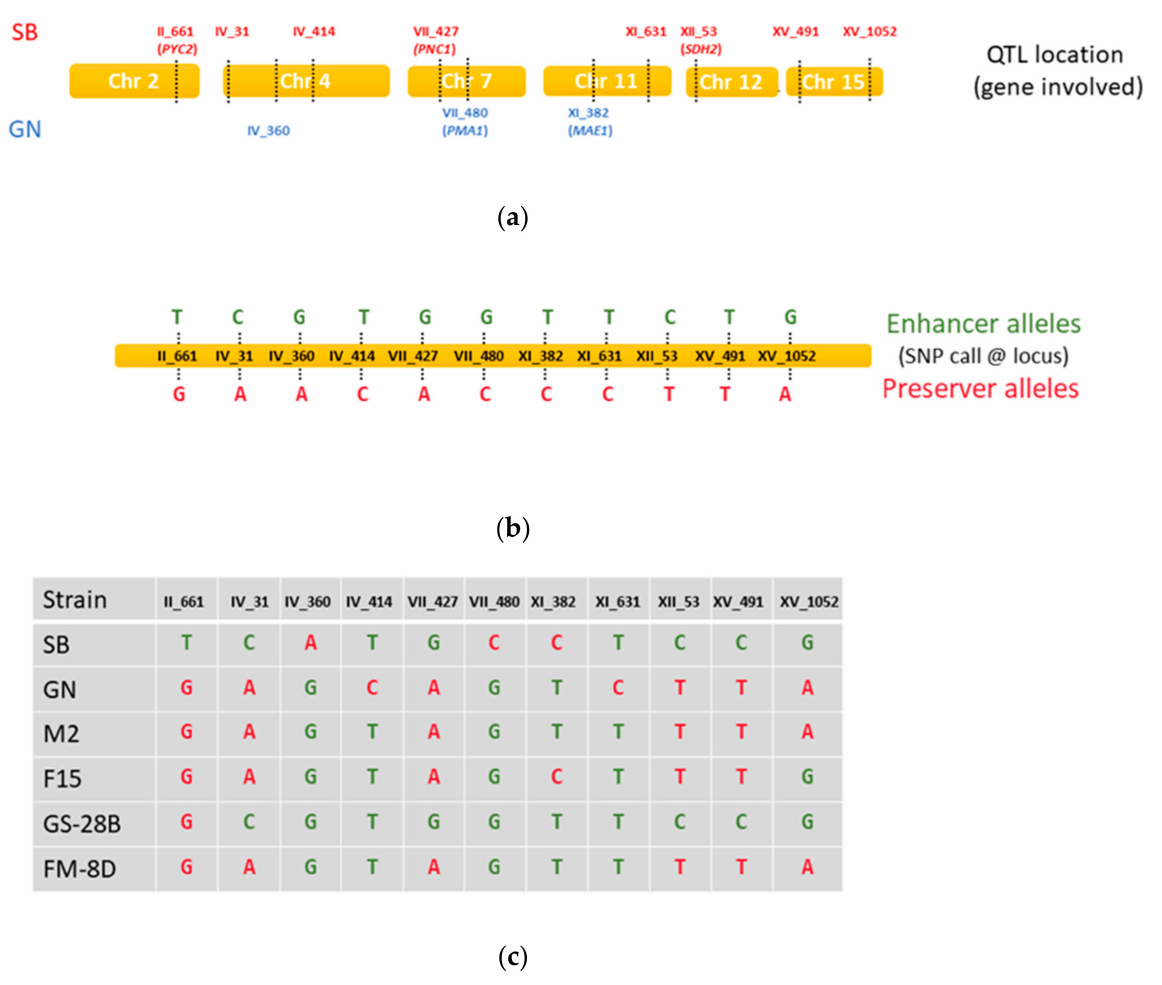
Figure 2. Quantitative trait loci (QTLs) tracked, and mass-array markers used, dotted lines represent the position of a marker. ( a ) Genetic position of the eleven QTLs mapped modulating malic acid consumption in SBxGN hybrid. The parental allele (GN or SB inheritance) promoting a stronger consumption was indicated for each locus. ( b ) SNP corresponding to the enhancer and preserver allele, the exact position is given in Table S1. ( c ) SNP call in the four founder and in the parental strains GS-28B and